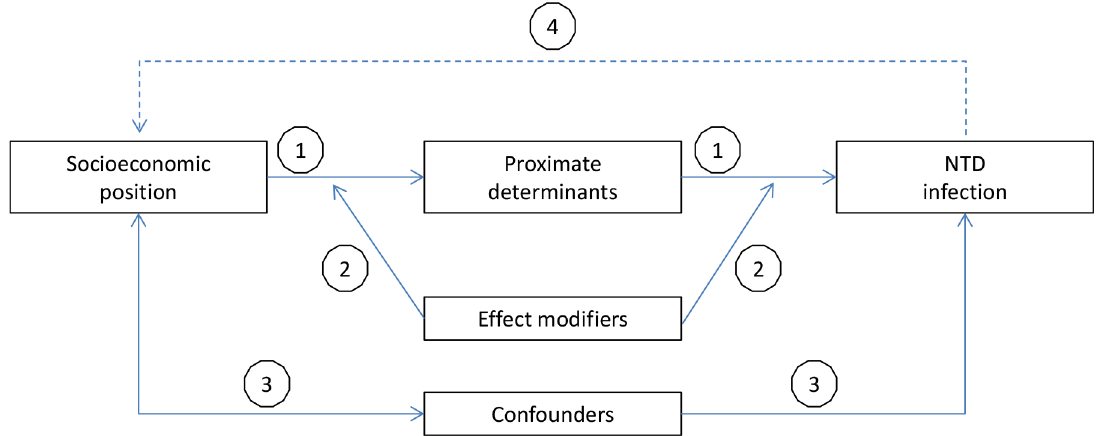
Fig 1. Analytical framework of the relationship between SEP and NTD infection. Note that we use NTD infection to signify the NTD and/or the underlying infection. Pathway (1) shows the effect of SEP on NTD infection via more proximate determinants of such infection, e.g., (lack of) sanitation facilities. The effect of SEP on NTD infection may be modified (2), e.g., by age. Associations between SEP and NTD infection may be partly explained by confounders (3), e.g., sex. Finally, NTD infection can also affect SEP (4). Dashed line: not the focus of our review (part of other reviews in this series). The framework is based on [11 –